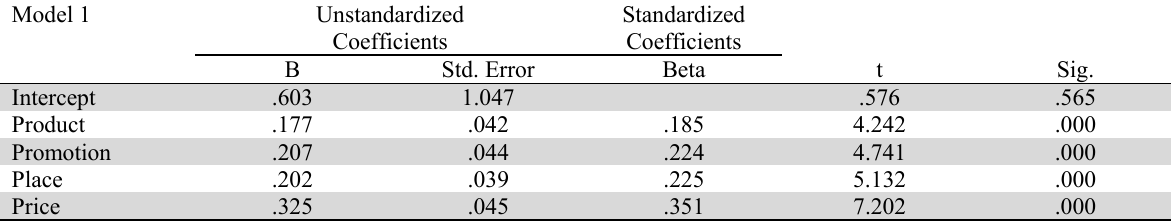
Standardized Coefficients